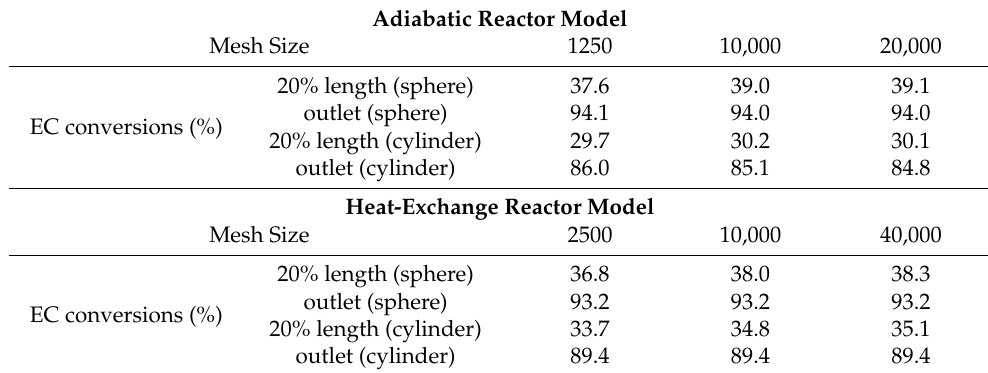
Table 2. Dependence of EC conversion on grid sizes in simulation.